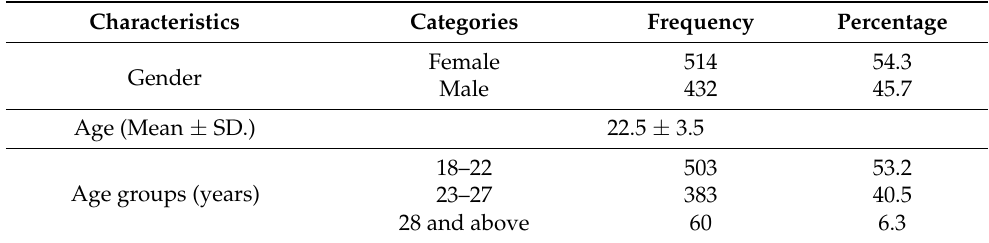
Table 1. Baseline socio-demographic data of the